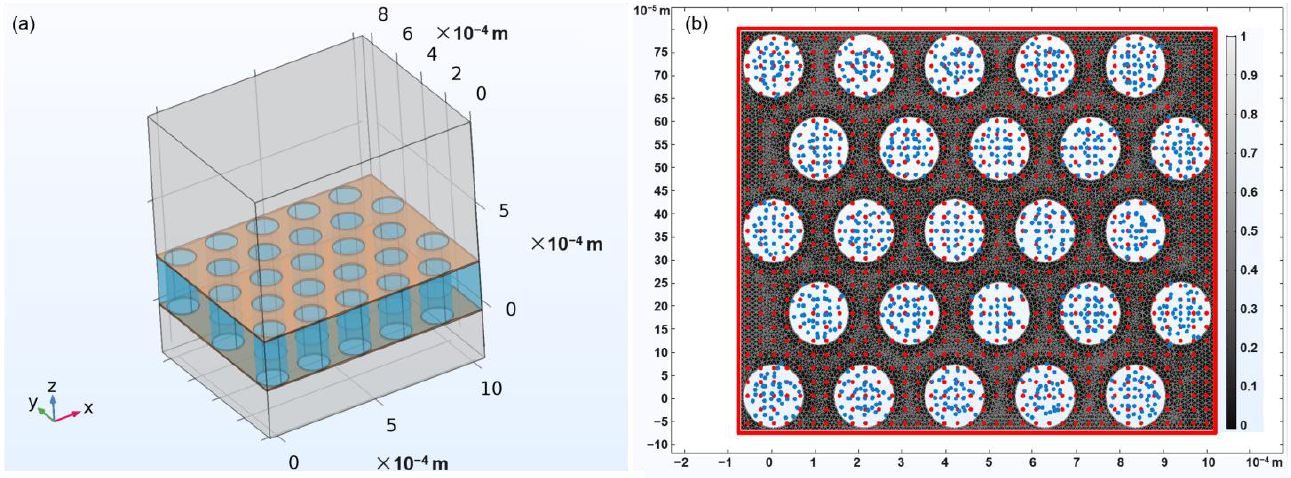
Figure 9. Electron trajectory tracking in a time projection chamber. ( a ) A simplified cavity structure model extracted from a TPC experimental setup. ( b ) A poincaré map of the particle trajectory. The red dots are the positions where the initially released particles are, the blue dots are the distribution states of the particles when they reach the upper surface of the GEM.